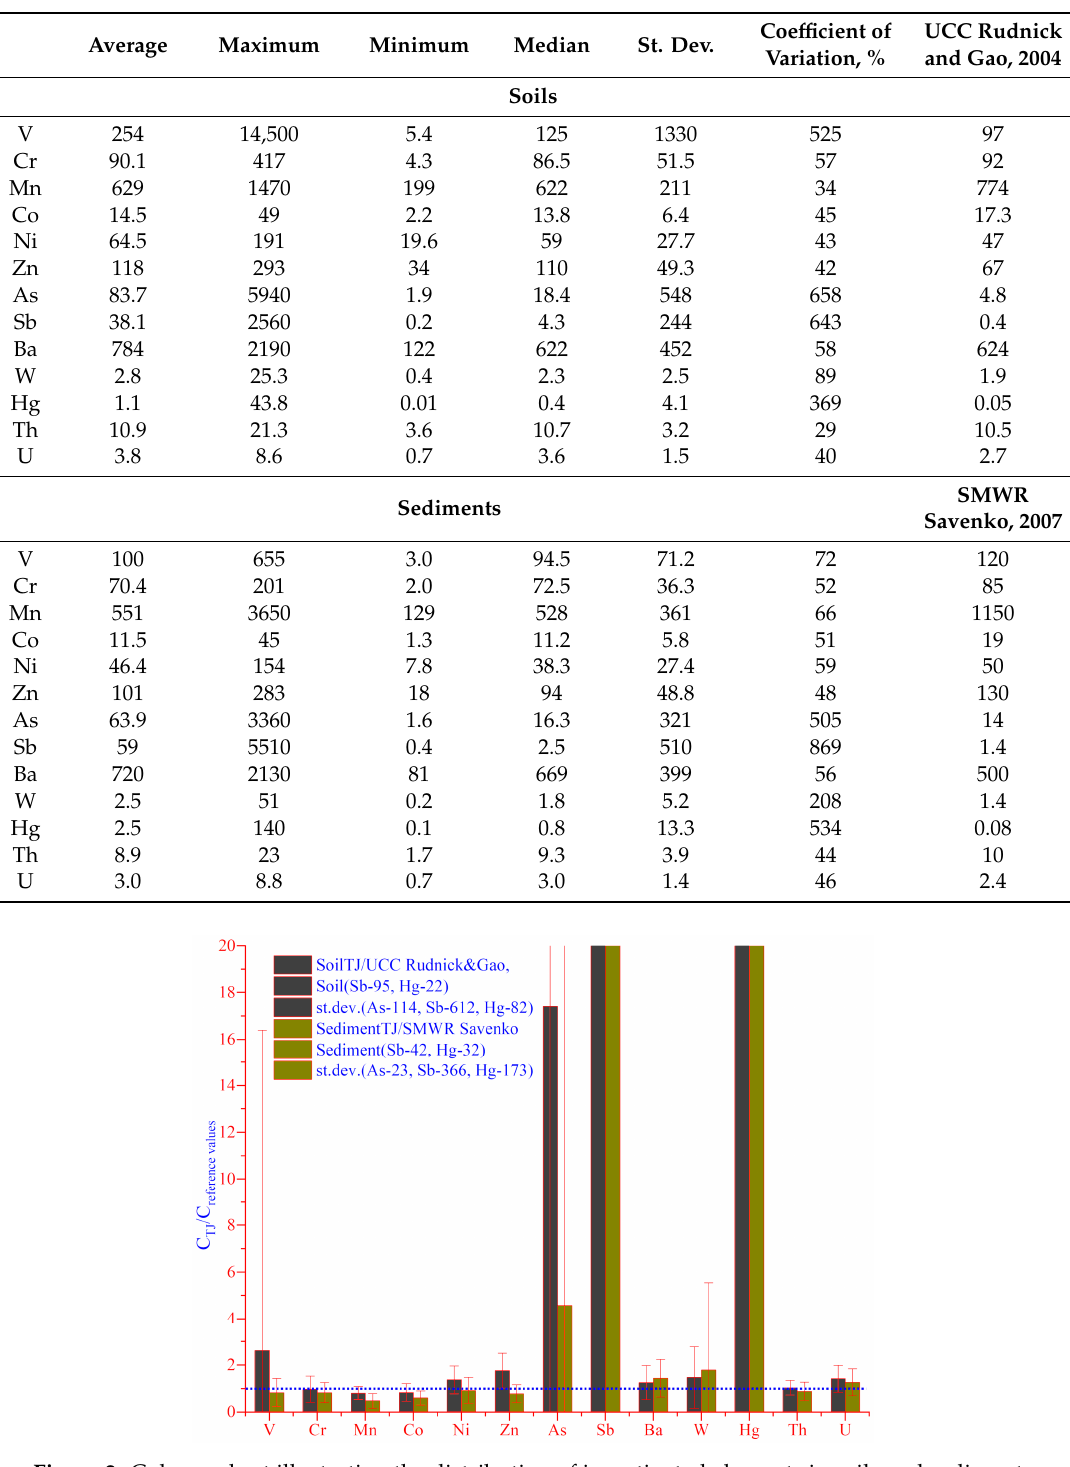
Table 2. Average, maximum, minimum, median, standard deviation and coe ffi cient of variation, regardingthedistributionof13toxicelementsinsoilsandsediments. Forcomparison, thecorresponding values of the upper continental crust (UCC) and the suspended materials of world rivers (SMWR) are also provided.